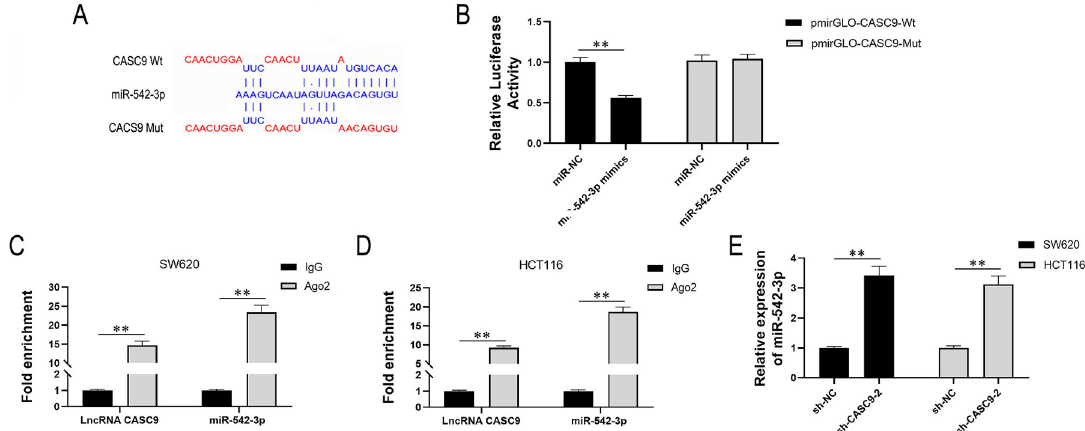
Fig 4. LncRNA CASC9 negatively regulates miR-542-3p by molecular sponge adsorption. (A) the binding sites for miR-542-3p in lncRNA CASC9 were prompted by bioinformatics analysis. (B) Dual-luciferase reporter gene assay showed that that the luciferase activity of the Wt reporter in the lncRNA CASC9-Wt+miR-542-3p mimics subset was significantly decreased compared to 3 other subsets. Black represents pmirGLO- CASC9 -Wt and grey represents pmirGLO- CASC9 -Mut in histograms. (C&D) In RNA-IP assay, the fold enrichment in the Ago2 subset was significantly higher than the IgG subset, which further confirmed lncRNA CASC9 could combine miR-542-3p by predicted binding sites both in SW620 and HCT116. Mouse IgG and human Ago2 were used in lncRNA CASC9 and miR-542-3p subsets of CRC cell lines. (E)The relative expression of miR-542-3p of both NC and sh- CASC9 -2 in SW620 and HCT116 were detected via qPCR, and downregulating lncRNA CASC9 upregulated miR-542-3p. Black represents SW620 and grey represents HCT116 in histograms. � P < 0.05 and �� P <